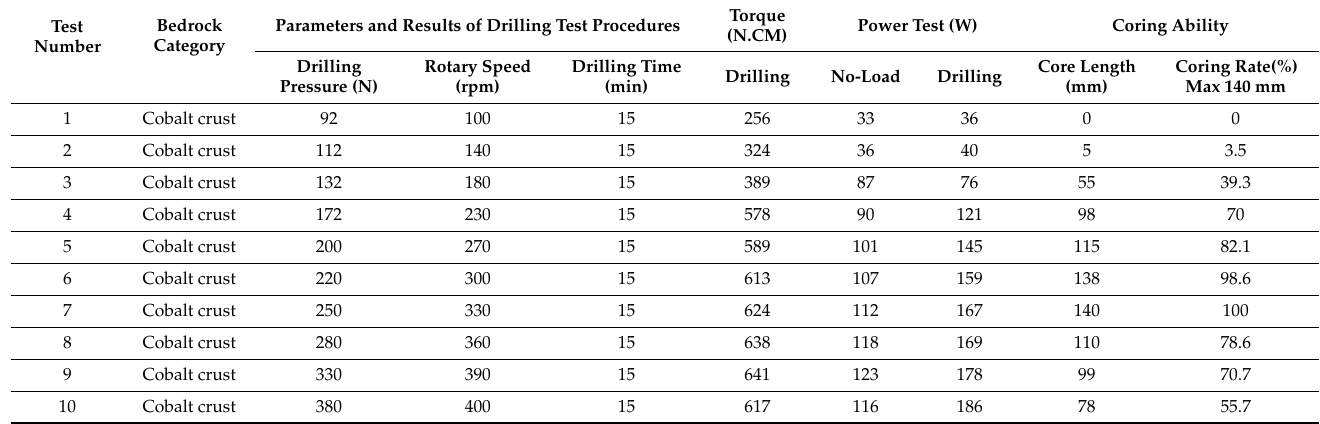
Table 5. Double parameter tests of Rotary Speed and drilling pressure (A2